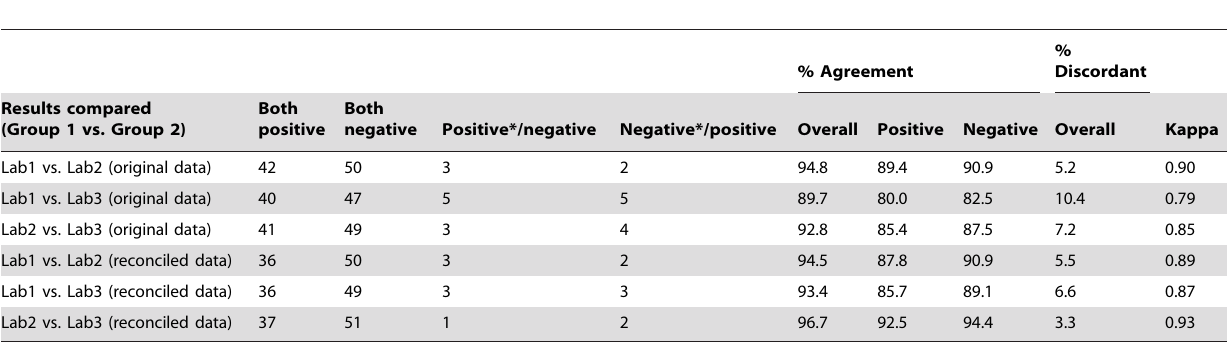
Table 3. Pairwise comparisons of QuantiFERON-TB Gold In-Tube test interpretations performed on the same subjects in three labs.